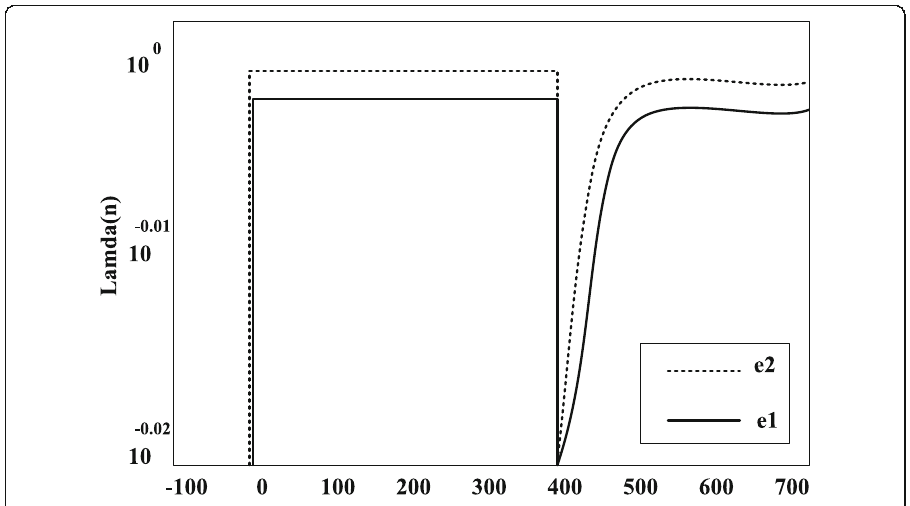
Fig. 2 Stable performance of the improved algorithm before and after the